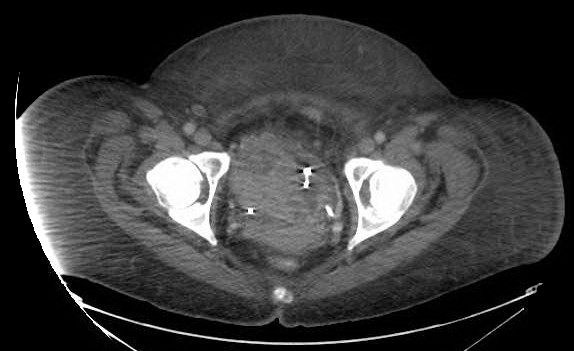
Computed tomography scan of the pelvis showing large nodular bladder mass with heterogeneous enhancement, prior to cystectomy. Exchange are most extensive along the right bladder wall though is also seen along the left bladder wall and fundus.